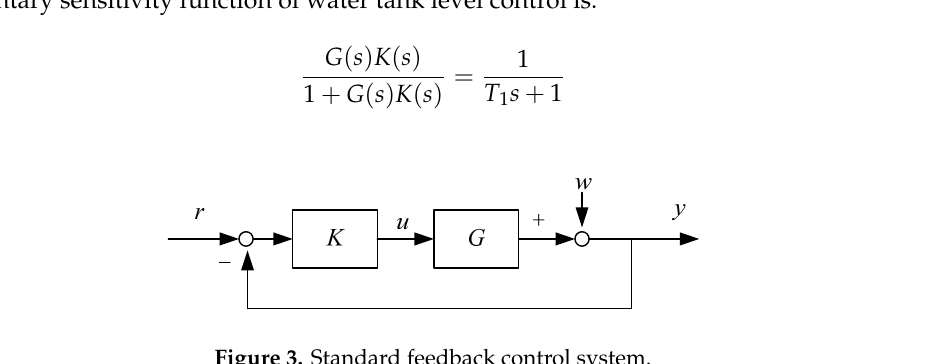
Figure 3. Standard feedback control system.